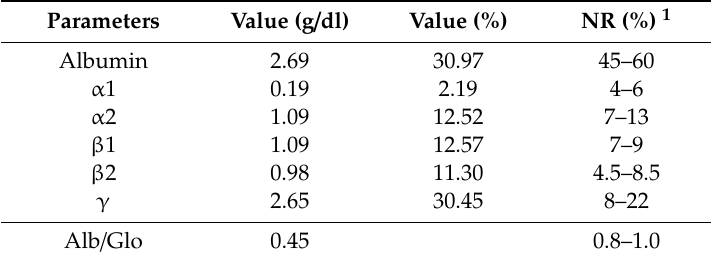
Table 3. Serum protein electrophoresis results from a horse a ff ected by a dermal geotrichosis for two months, with severe dermatitis, showing also fever, inappetence, elevated heart and respiratory rate at the time of blood sampling.